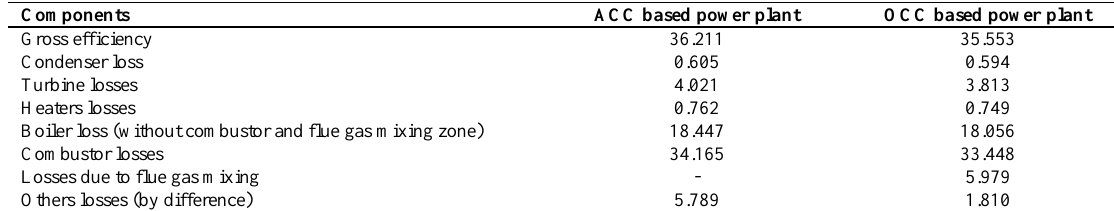
Table 3. Comparative exergy analysis at full